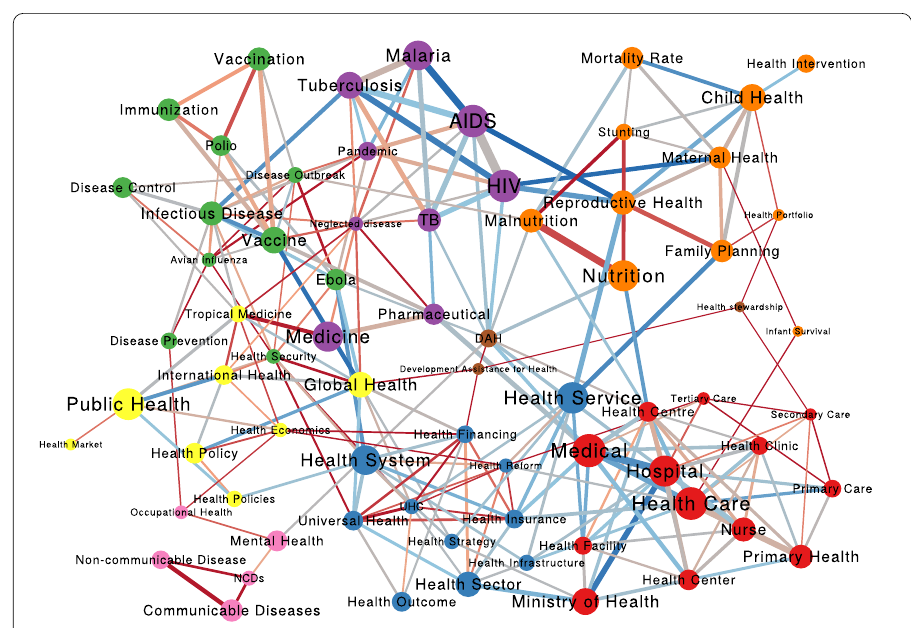
Figure 3 The issue co-citation network. Each node is a health issue. The node’s size is relative to its aggregate WS value. The node color reflects the network community. Edges are sized according to their WS , and colored according to their